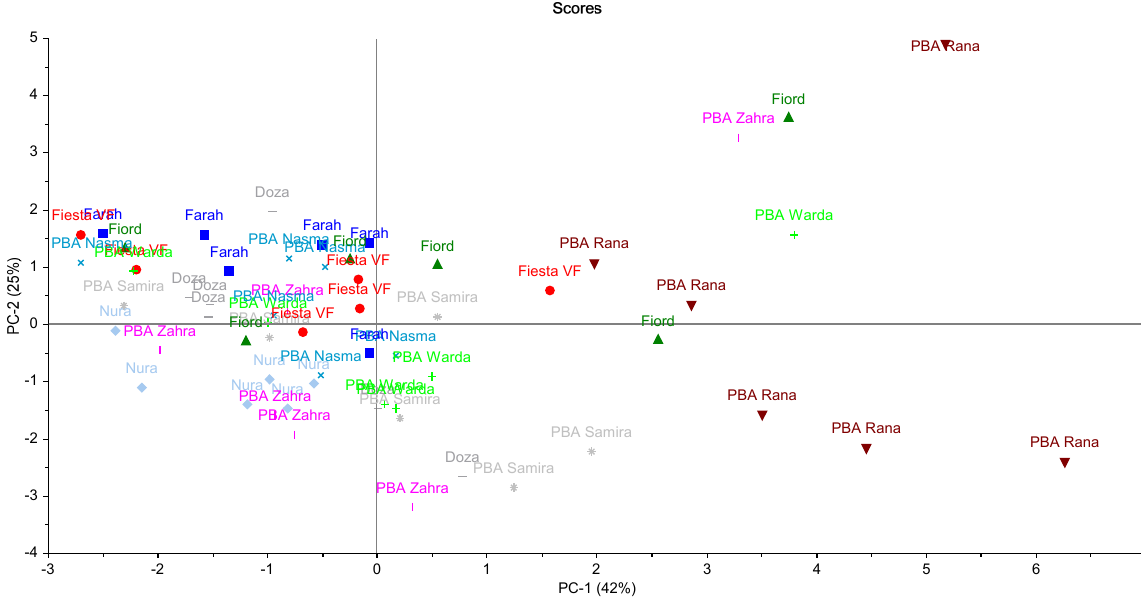
Figure 3. Scores plot showing the results of the principal component analysis performed on the normalised phenolic data. Each faba bean variety is indicated by a different symbol color and shape.